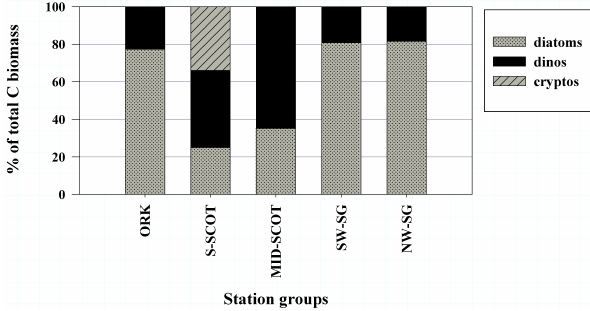
Fig. 4. Microplankton community composition in terms of carbon biomass of the station groups for the 2008